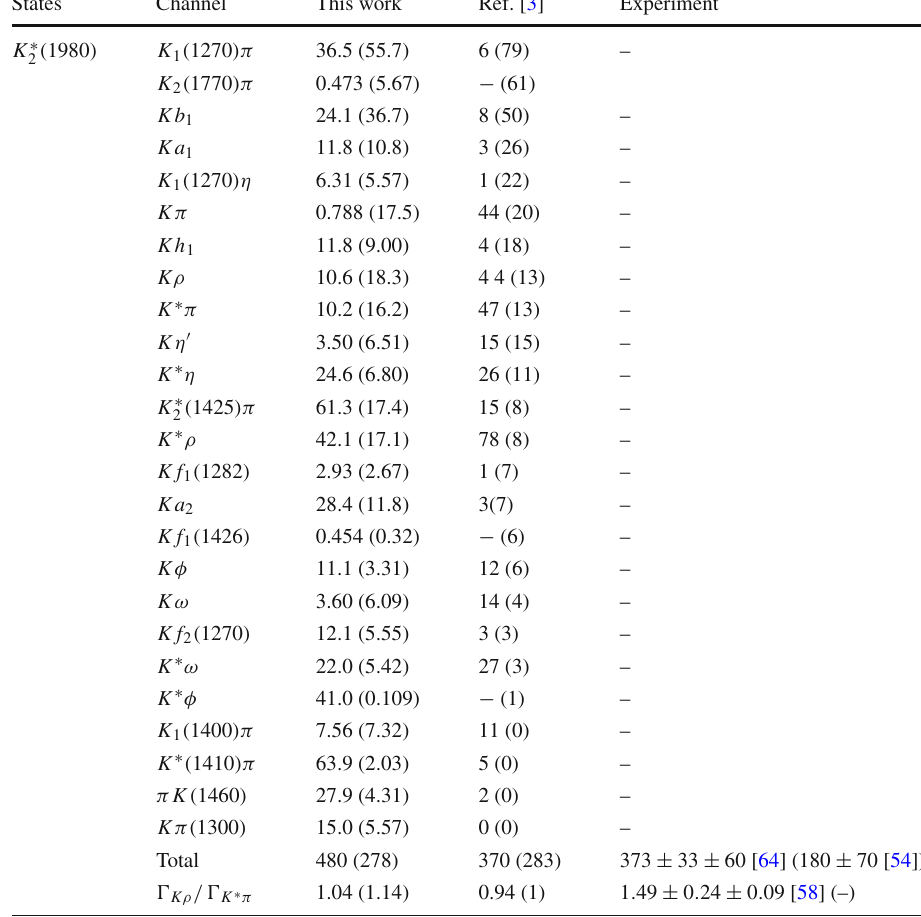
Table 7 The strong decay States ( 1980 ) , where the widths of K ∗ 2 values in brackets and without brackets in the third and fourth columns represent those for ( 1980 ) as the 1 3 F 3 P K ∗ 2 and 2 2 2 states, respectively. The unit of the width is MeV